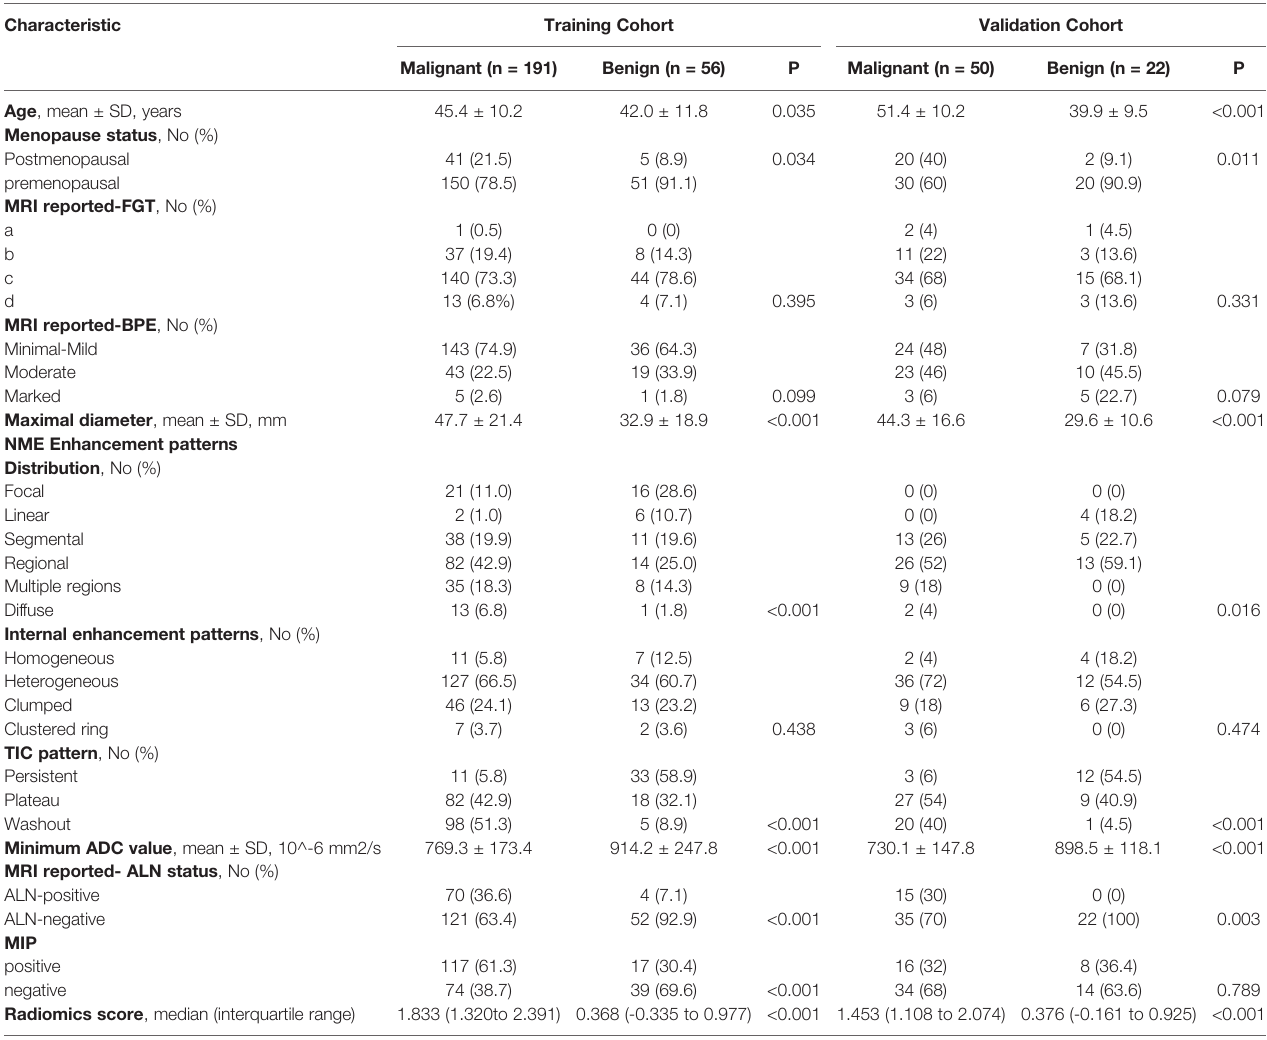
TABLE 2 | Characteristics of patients in the training and validation cohorts.